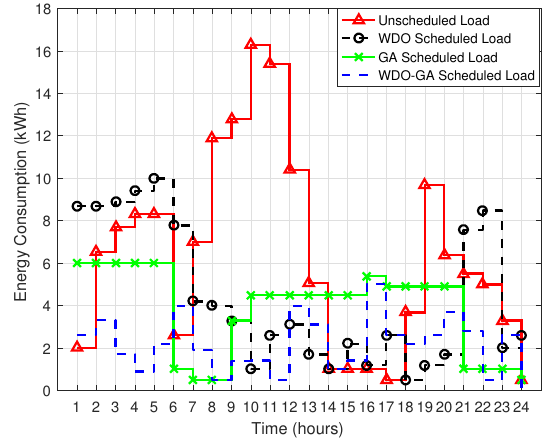
Figure 5. Energy